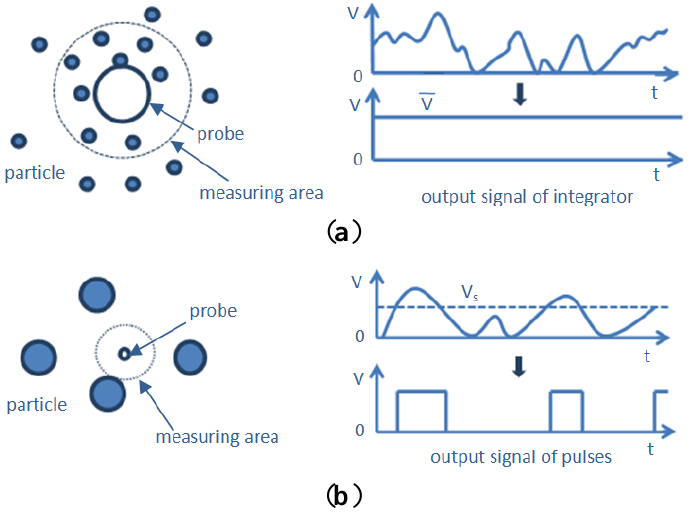
Figure 2. Two categories of reflection-type probe